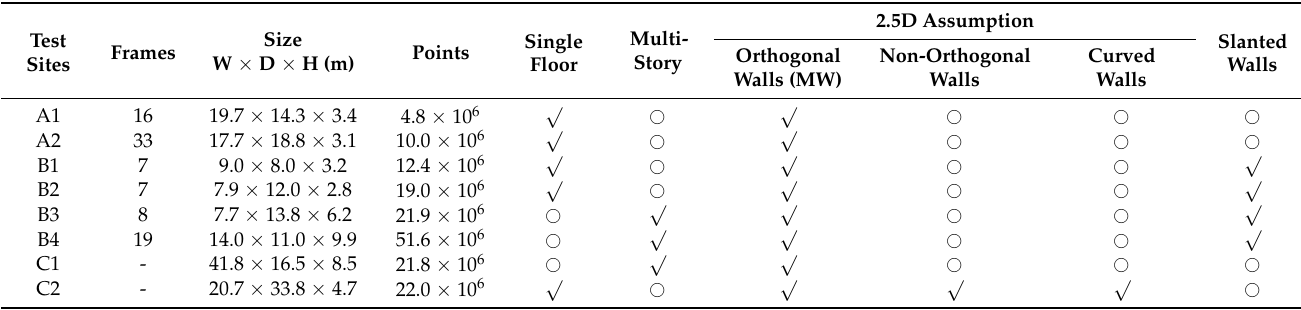
Table 1. Detailed descriptions of the experimental datasets.